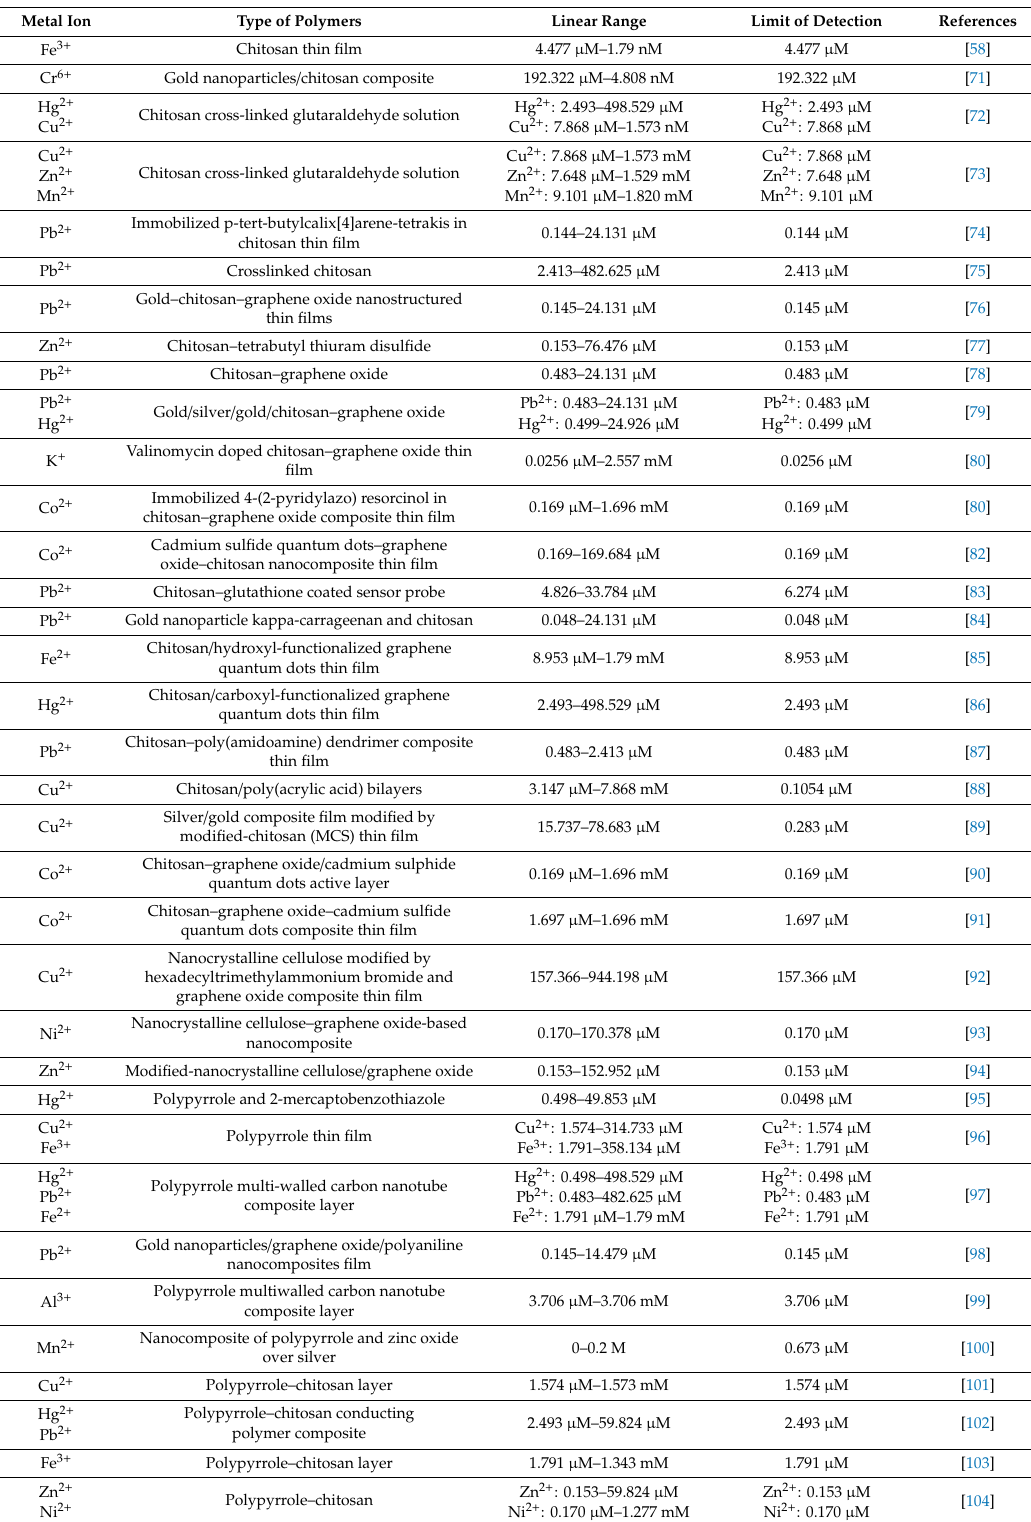
Table 2. The biopolymers and conducting polymers based on surface plasmon resonance for metal ion